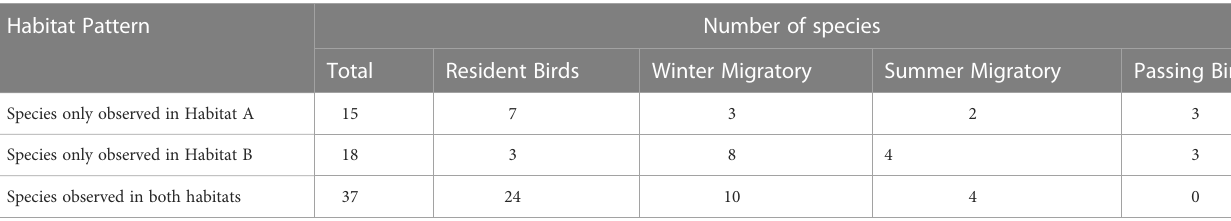
TABLE 4 The records of bird species numbers in different habitat pattern. Habitat